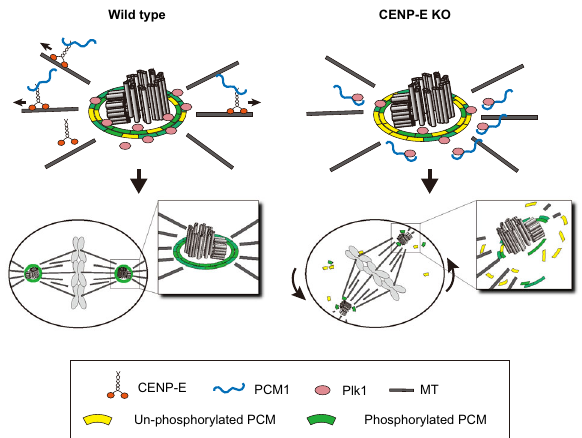
Fig. 9 A model summarizing results in this study. Interphase CENP-E removes PCM1 from the vicinity of the centrosome by prophase, during which time Plk1 phosphorylates PCM. In the CENP-E KO, PCM1 remains around the centrosome even in prophase, Plk1 is sequestered by PCM1, and phosphorylation levels of PCM decline. Insuf fi ciently phosphorylated PCM is fragmented during mitosis, resulting in chromosome mis-orientation and oblique